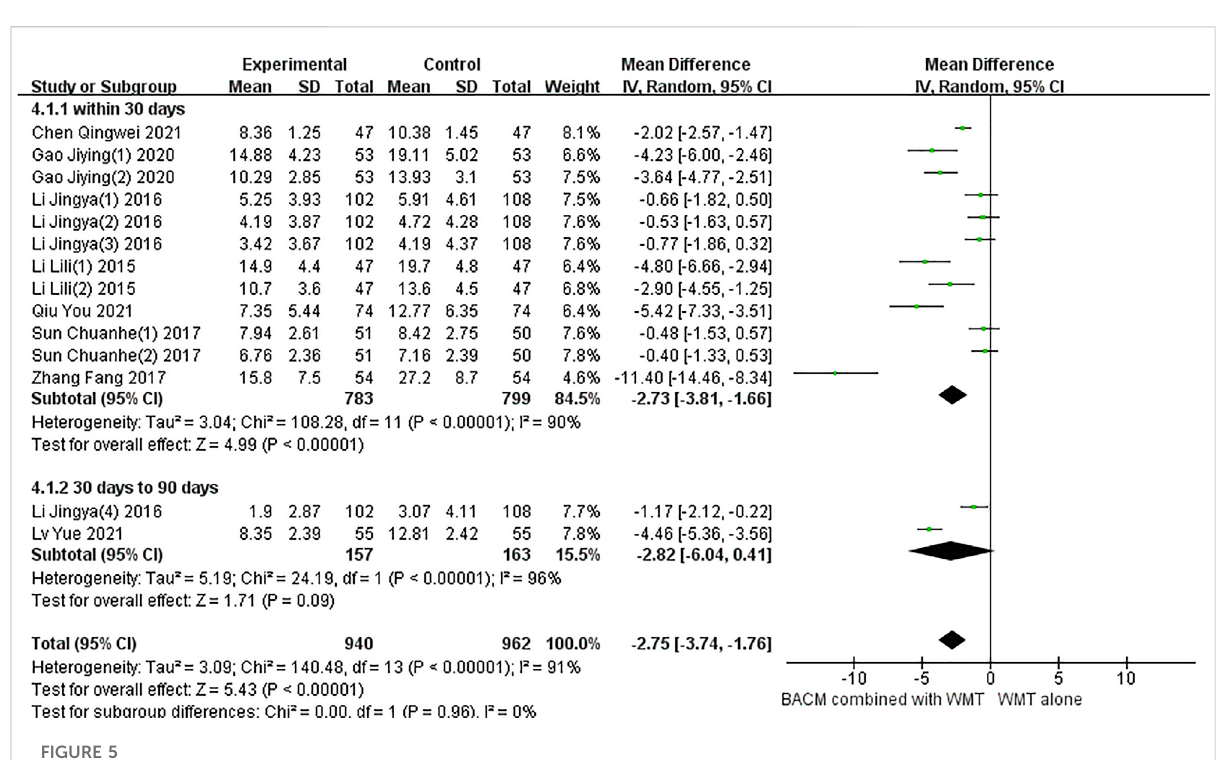
FIGURE 5 The forest plot demonstrating improvement of NIHSS by BACM for